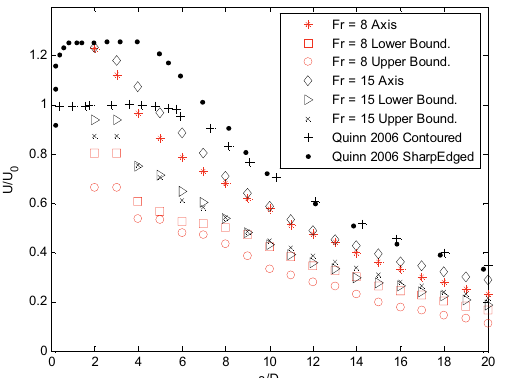
Figure 4. Streamwise non-dimensional mean velocity for INBJ with Re = 1000, θ = 65° and decay U/U 0 different Fr along the axis (asterisks Fr=8, rhombi Fr=15) and in the upper (circles Fr=8, crosses Fr=15) and lower (squares Fr= 8, triangles Fr=15) region of the near-field, and of two simple jets (Quinn 2006 [14]; sharp-edged orifice: black dots; contoured orifice: black plus sign); the upper and lower boundary decays are measured in correspondence to the widening of a simple jet.